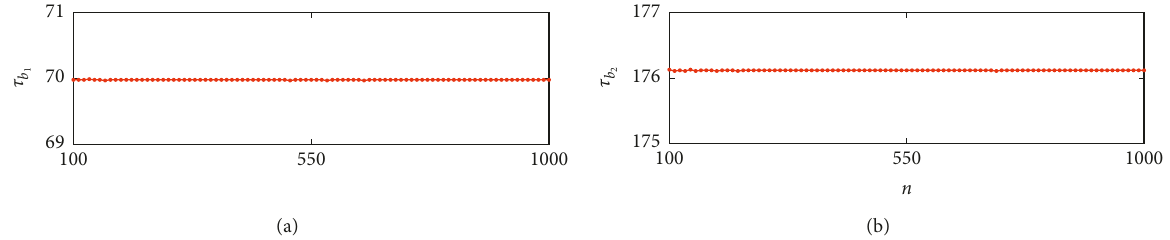
Figure 6: Variation in bifurcation delay (a) τ